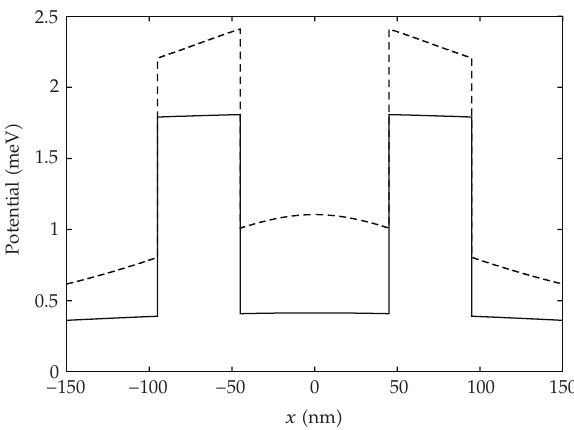
Figure 8: The total potential experienced by the ballistic electron when the qubit is in the initial states | 0 (cid:2) (cid:9) solid line (cid:10) and | 1 (cid:2) (cid:9) dashed line (cid:10) .